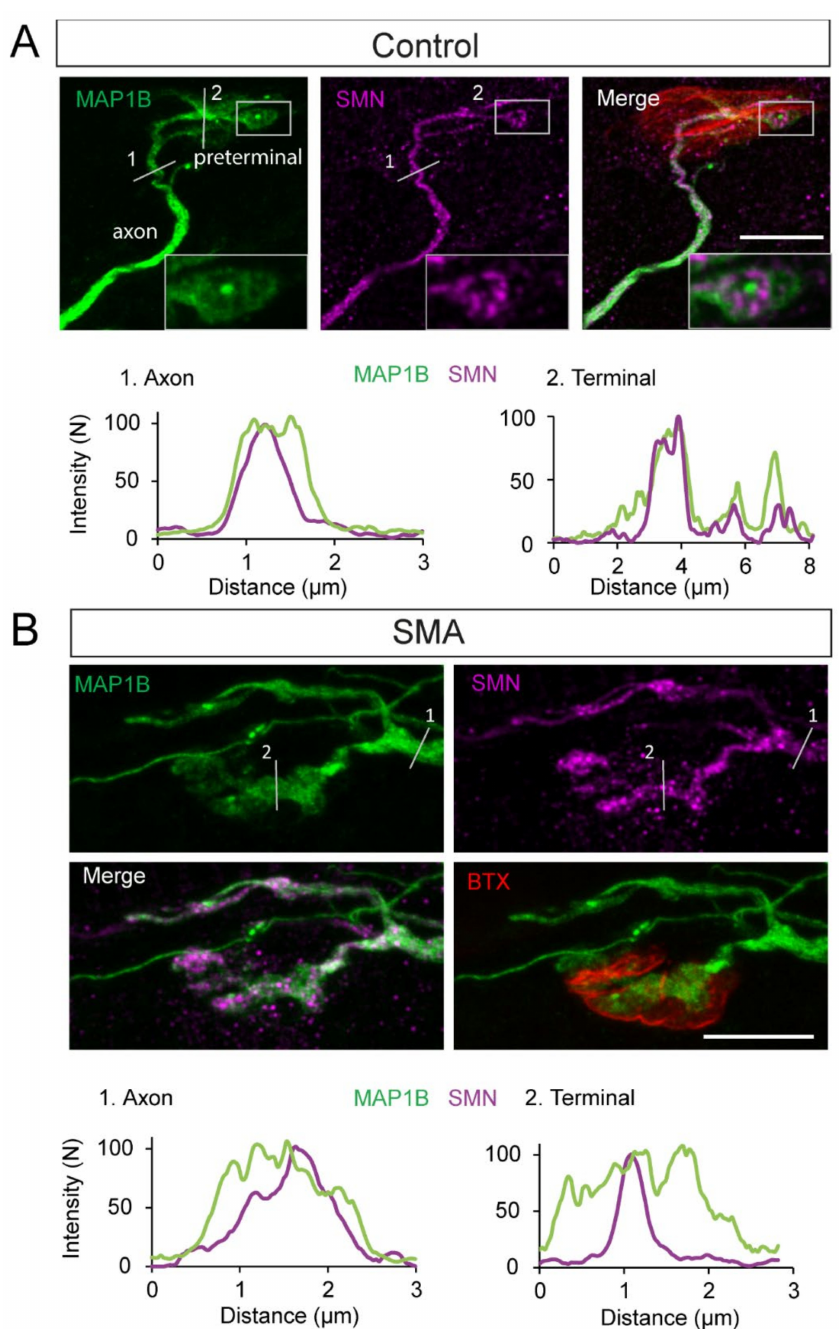
Figure 6. SMN granules are spatially associated with MAP1B at presynaptic motor terminals. ( A ). SMN granules (magenta) follow the MAP1B trajectory (green) in control mice, both in the axon and the presynaptic terminal. MAP1B can form rounded structures containing organized SMN granules (inset) at the most distal portions of the intraterminal branches. The linear intensity profile of MAP1B (green) and SMN (magenta) in segments 1 and 2 in the images are shown in the lower graphs. ( B ). In SMA mice, MAP1B has a diffuse appearance. Linear intensity profile of MAP1B (green) and SMN (magenta) in segments 1 and 2 indicated in lower graphs. Note that the MAP1B signal encompasses the SMN signal. Scale bars: 10 µ